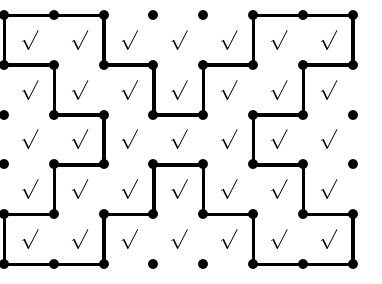
Figure 8. Input and output of Slitherlink generation; example